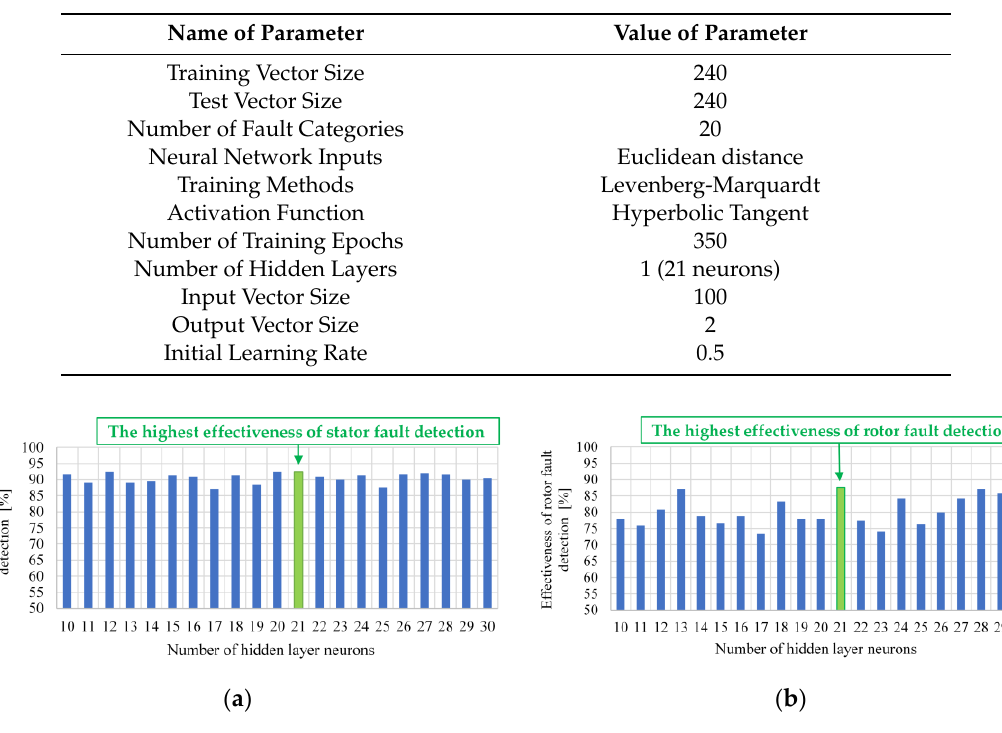
Figure 8. E ff ectiveness of motor fault detection by the MLP network: ( a ) broken rotor bars; ( b ) stator winding faults.